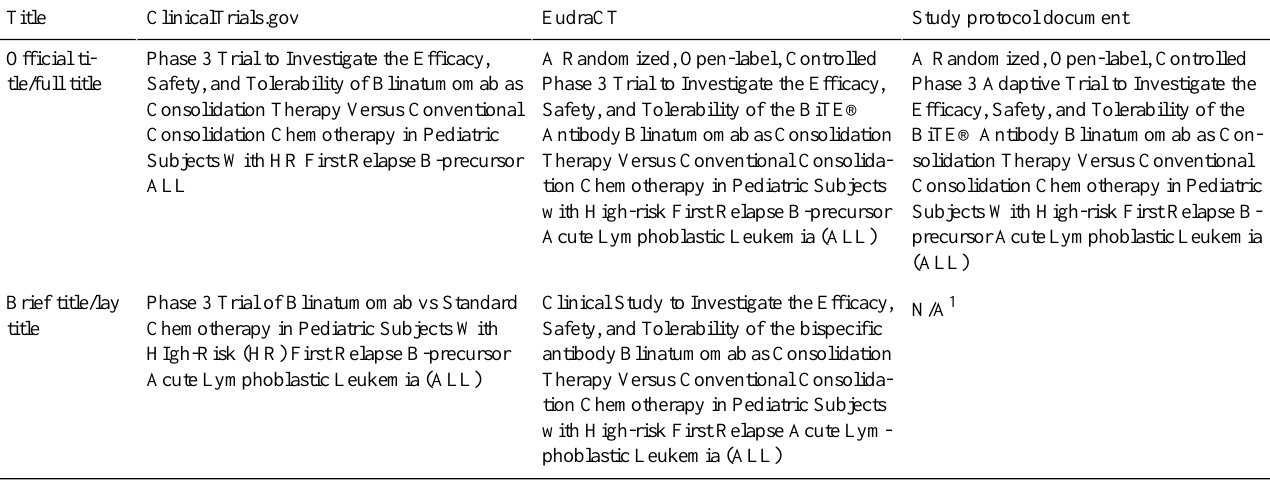
Table 3. Comparison of different study titles for the NCT02393859 trial. Titles were copied verbatim from [40] and [41].